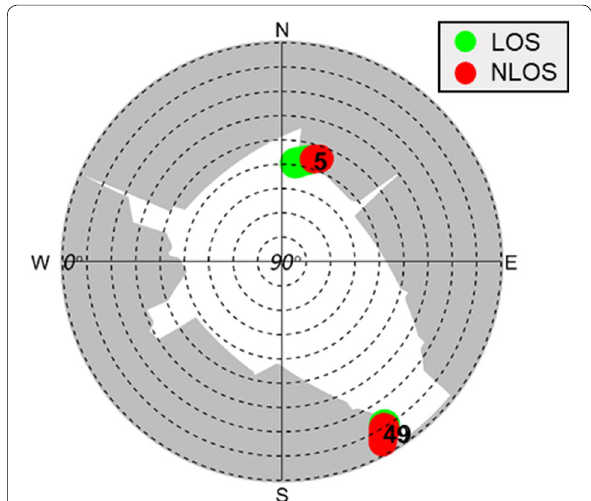
Fig. 11 Demonstration of the satellite visibility transition